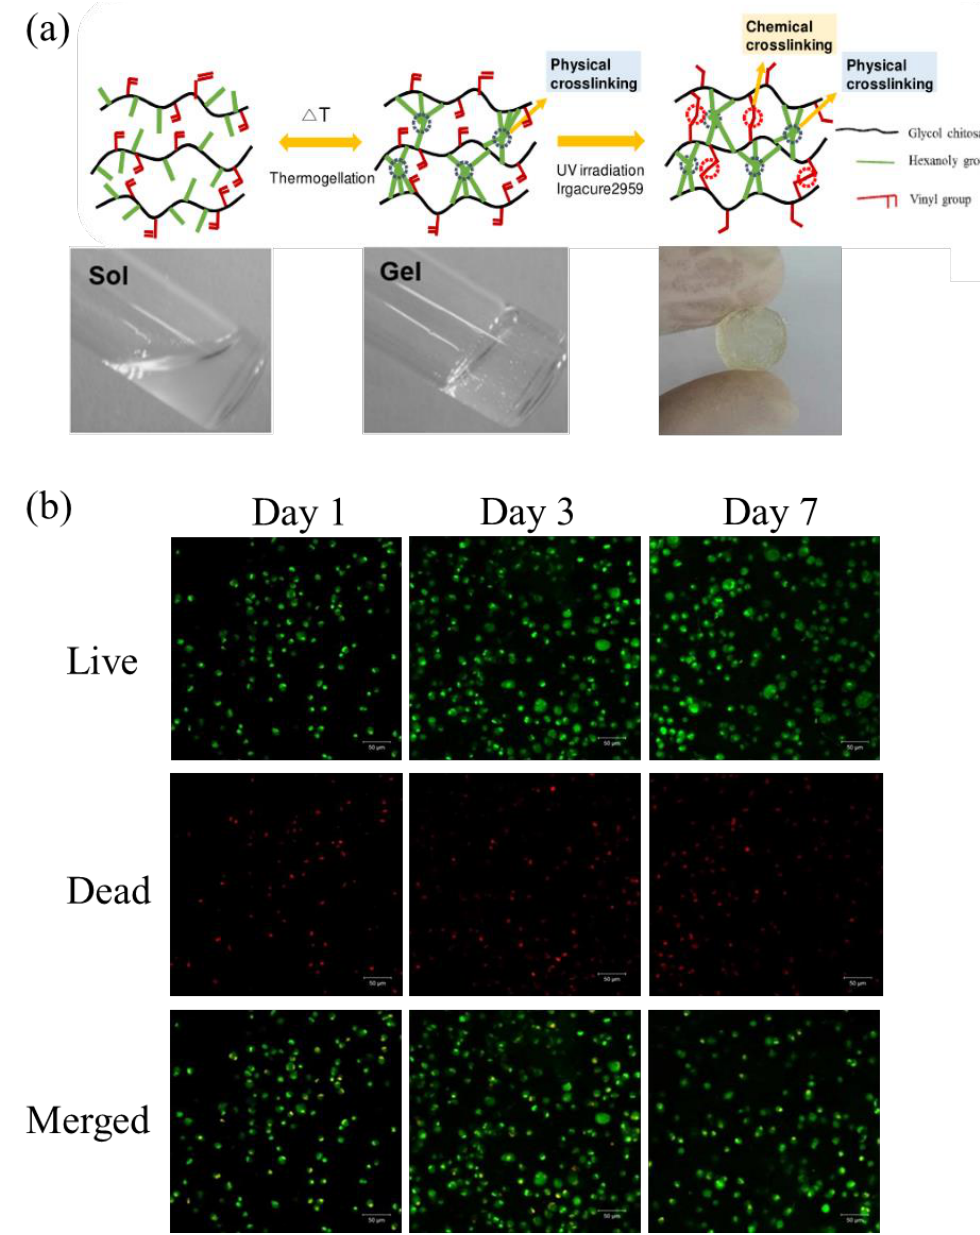
Figure 10. ( a ) Schematic illustration of thermo-reversible sol–gel transition and photo-345 crosslinked hydrogel formation upon UV irradiation; ( b ) Live/dead imaging of encapsulated chondrocyte cells within the photo-crosslinked M5-HGC hydrogels at 1, 3, and 7 days. Reprinted with permission from Ref. [110]. Copyright 2016, copyright with permission from Cho.